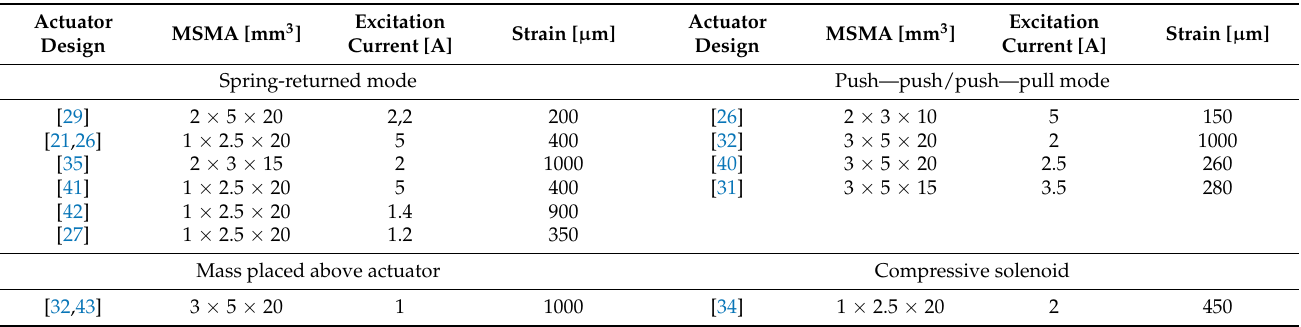
Table 1. Parameters of MSMA-based actuators presented in the literature.